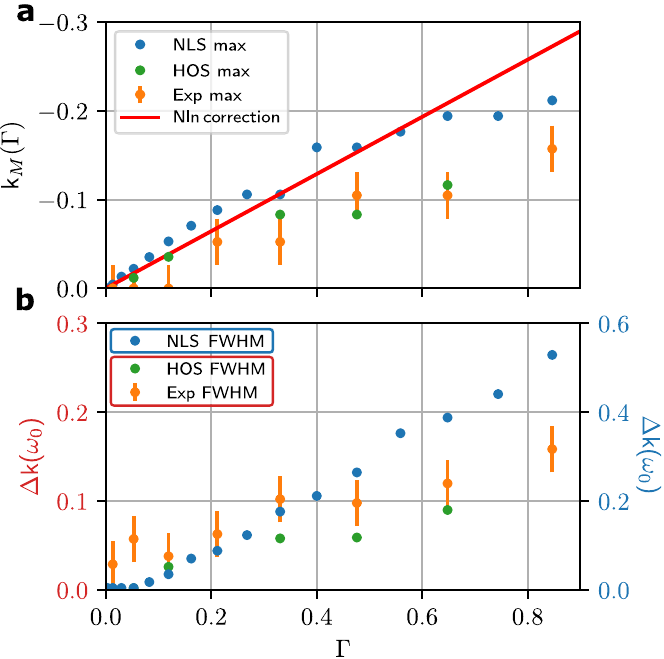
Figure 5. Quantitative comparison of the experimental results with different numerical models as a function of 0 . Blue and green dots correspond to NLS and HOS simulations; Ŵ . (a) Value of k at the NDR maximum for ω = orange dots show experimental data. Red line represents the theoretical curve (Eq. 5). (b) Full width at half 0 . Note that the vertical scale is different for experiments/HOS simulations (left maximum of the NDR for ω = scale) and 1DNLSE simulations (right scale). For all points in ( a,b) , f 0 = 1.15 Hz, (cid:31) f = 0.2